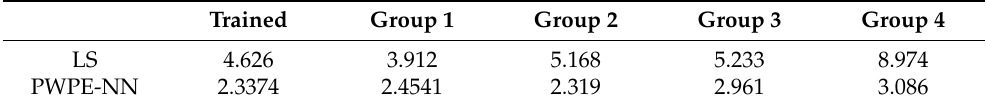
Table 1. Mean square error of phase measurement (10 − 4 )